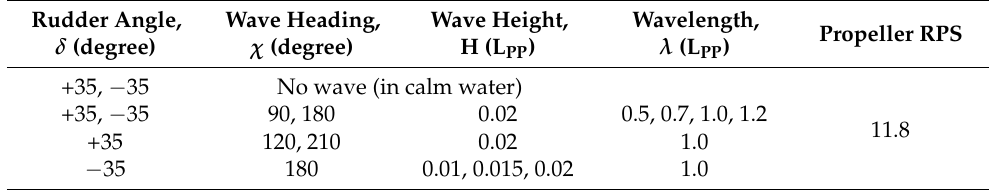
Table 3. Numerical simulation conditions.